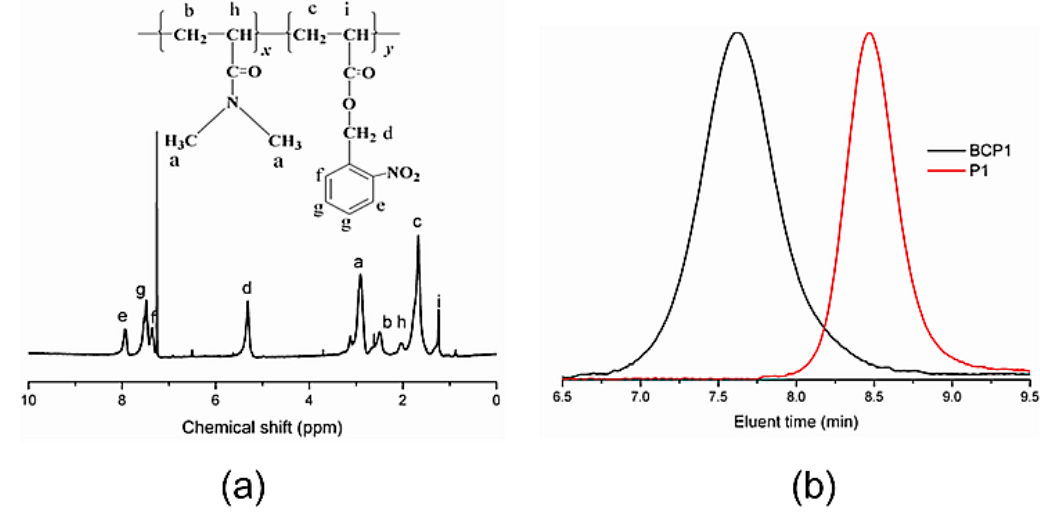
Figure 1. Characterization of PDMA 30 -b- PNBA 97 : ( a ) its 1 H - NMR spectrum in CCl 3 D; and ( b ) the GPC elution curve in THF using polystyrene standards for calibration. CCl 3 D: chloroform-d; THF: tetrahydrofuran.